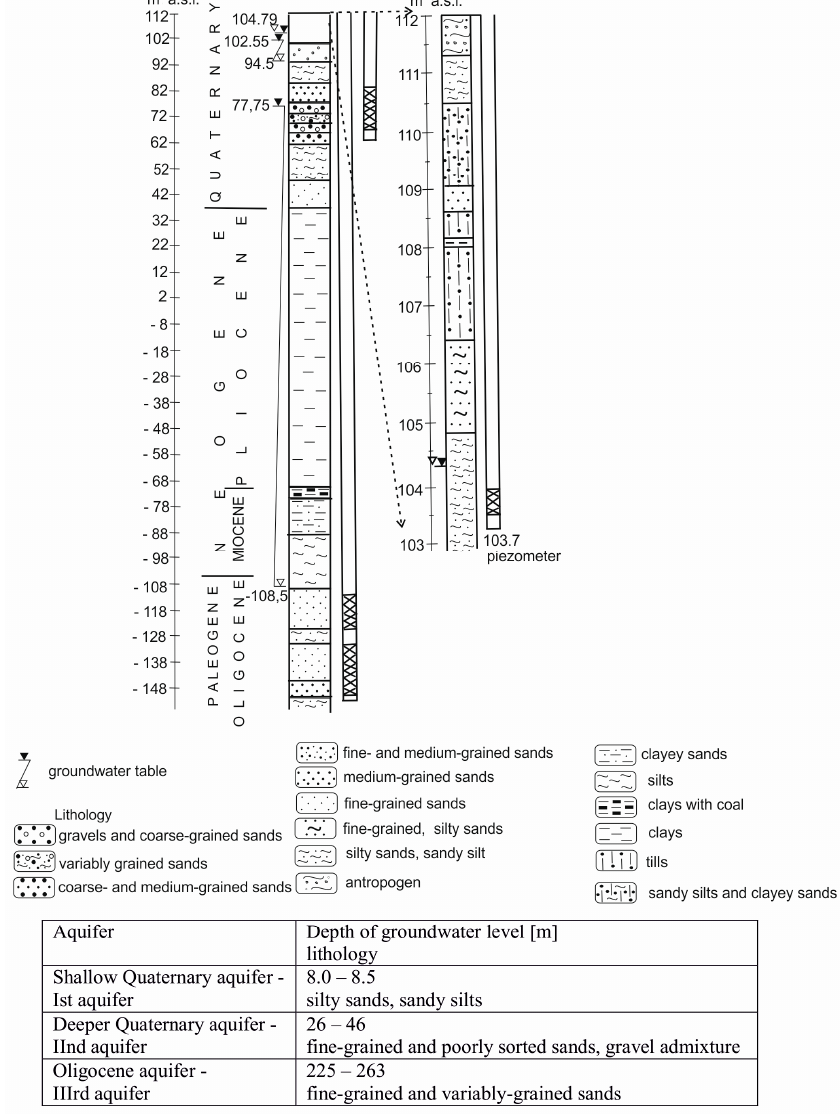
Figure 2. Geological profile and location of the groundwater tables in aquifers.